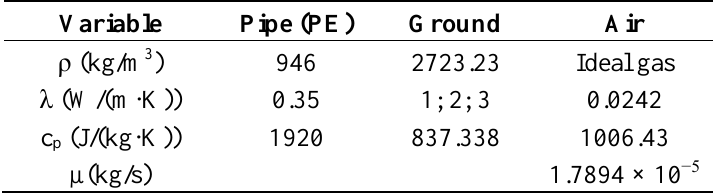
Table 2. Main properties of the materials used in the